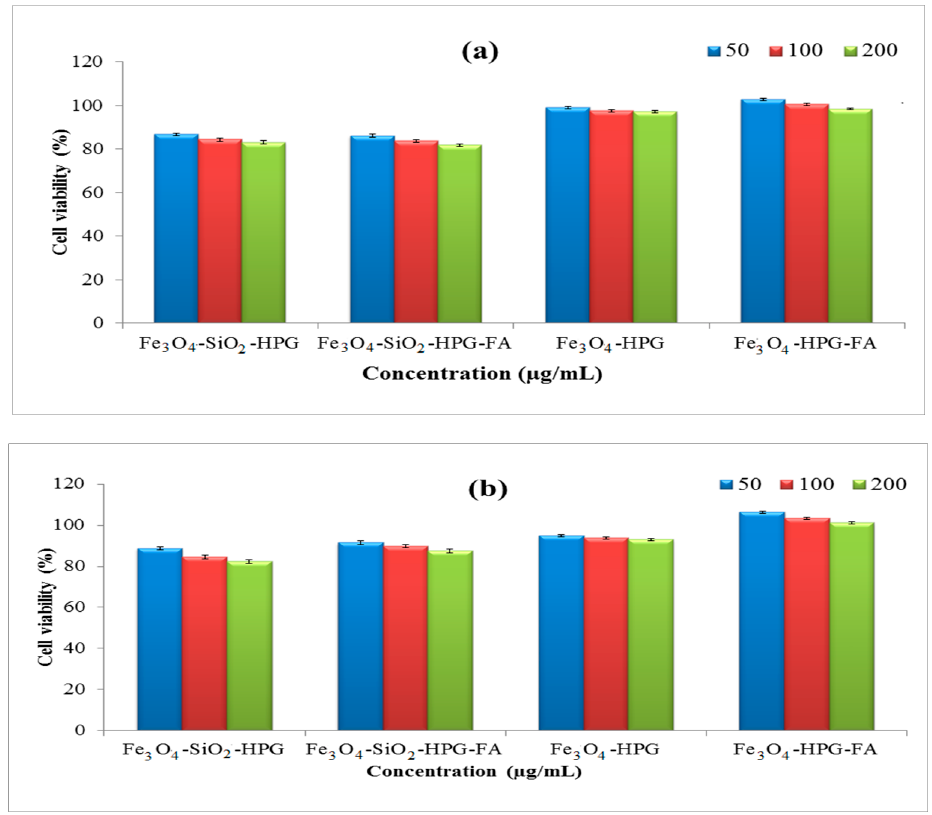
Figure 5. cytotoxicity evaluation of nanoparticles after ( a ) 24 h and ( b ) 48 h on the MCF-7 cell line .